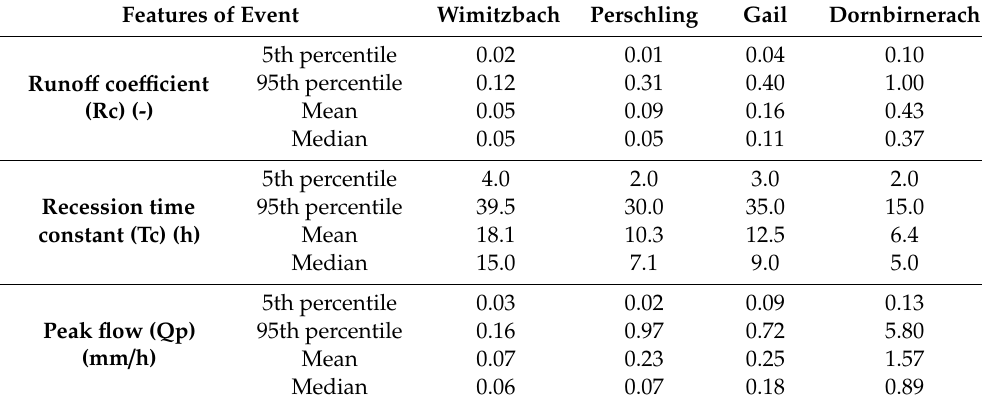
Table 3. Summary of event runo ff characteristics in Wimitzbach, Perschling, Gail, and Dornbirnerach catchments in the period